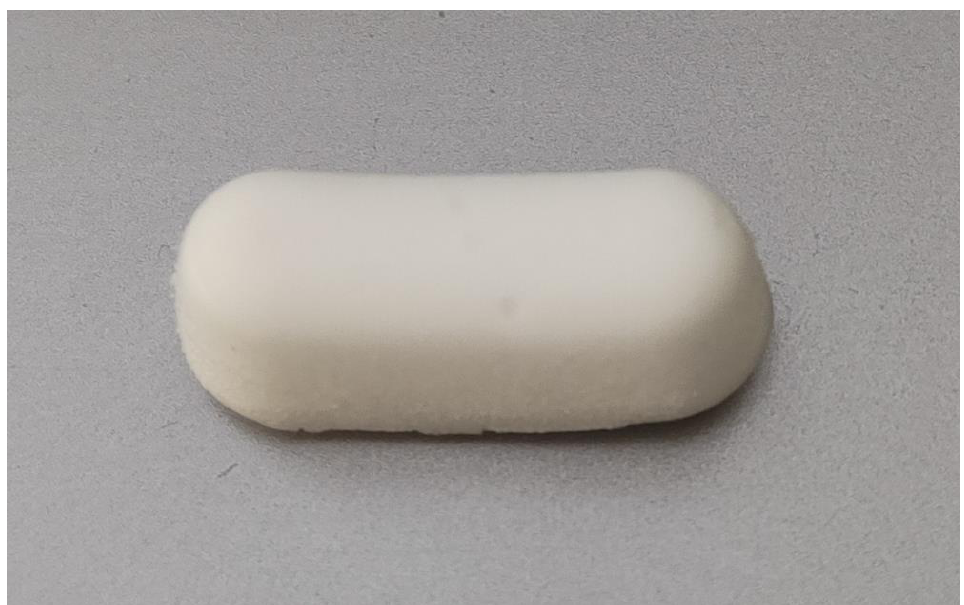
Figure 1. The HA + OCT device has a shape of a cuboid with round edges, white color, sponge-like consistency, and size of 20 × 5 × 5 mm.